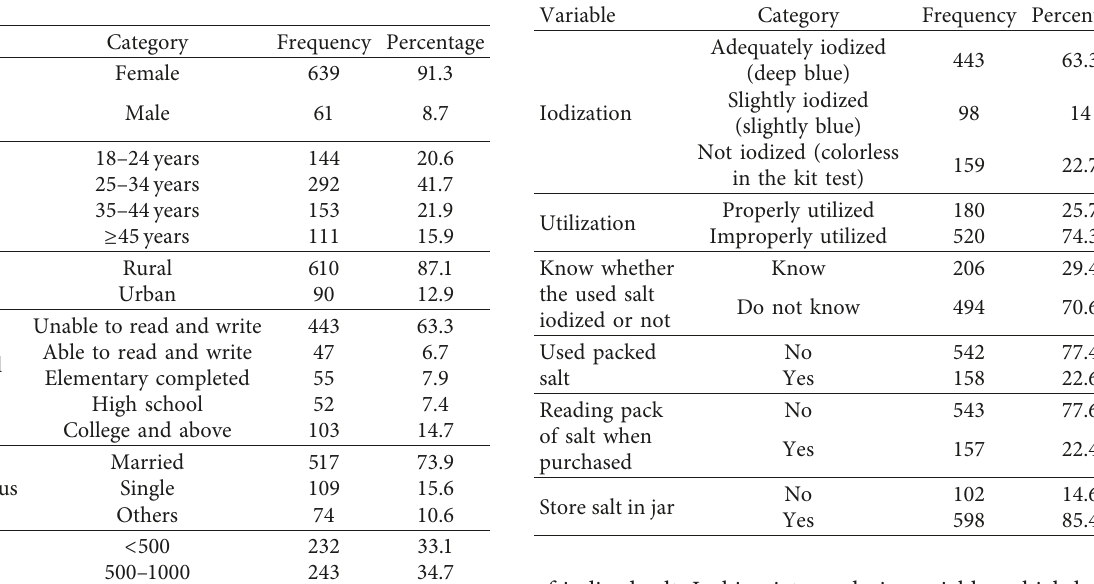
of iodized salt. In bivariate analysis, variables which had P value < 0.2 entered into multivariate logistic regression analysis. Factors which had significant association on bi- variate analysis on knowledge were sex of the head of households, age of the head of household, educational status, residence, family income, and occupational status. Among